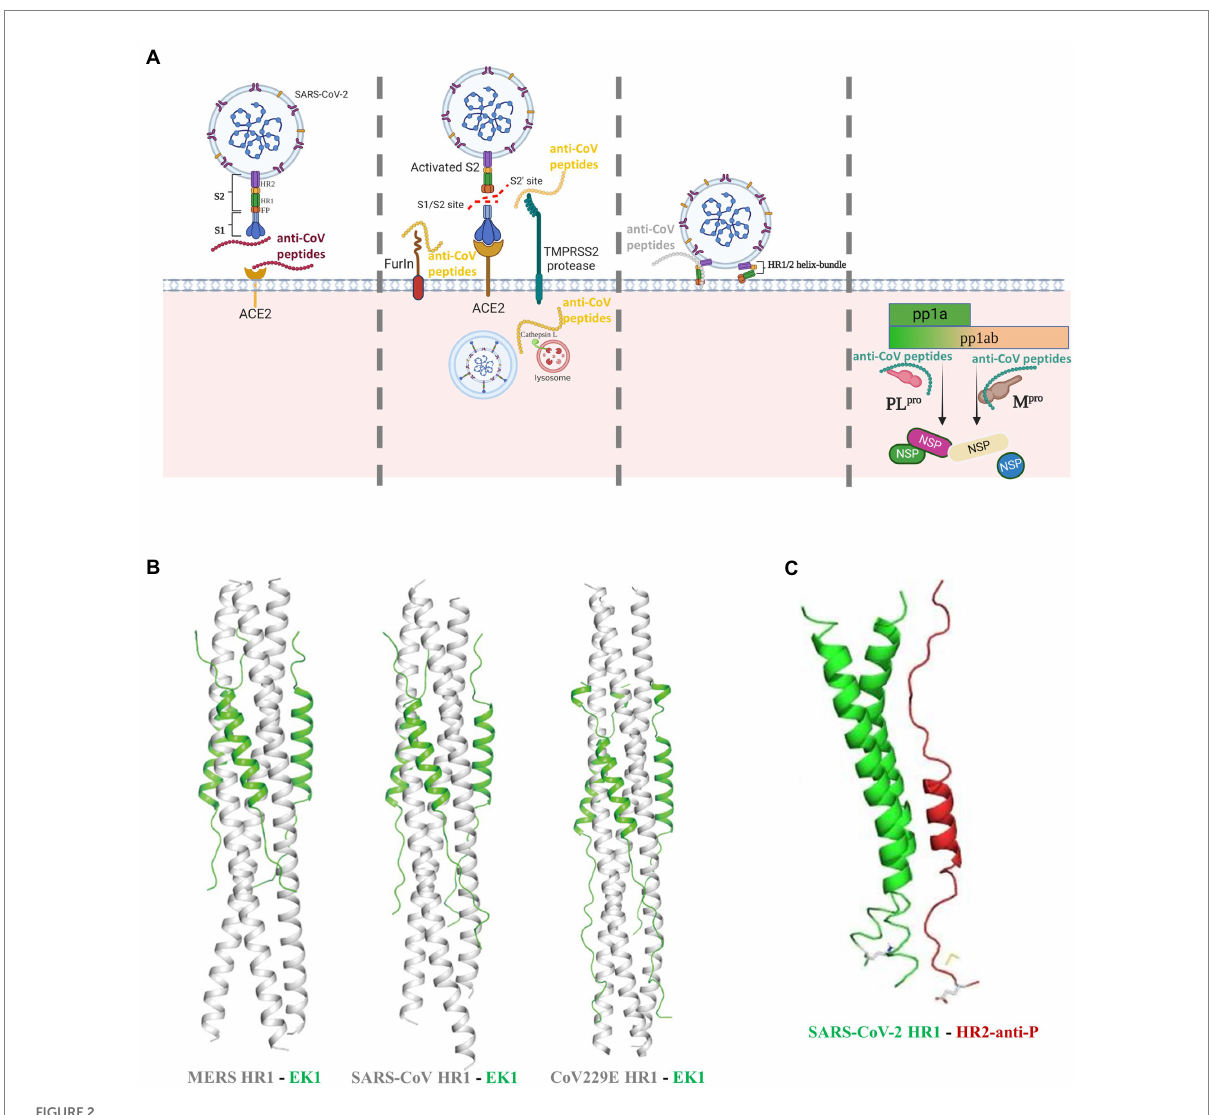
FIGURE 2 Peptides as potent inhibitors against coronavirus. (A) Anti-CoV peptides can work with diverse modes of actions by targeting the binding of S protein to host receptor, or the proteolytic processing of S proteins by host proteases, or the host-viral membrane fusion, or the viral proteases that are responsible for cleavage of replicase polyproteins into non-structural proteins. (B) The X-ray crystal structures of membrane-fusion inhibitory peptide EK1 shown as green in complex with the S protein HR1 regions of various CoVs shown as white (Xia et al., 2019b). (C) The X-ray crystal structures of membrane-fusion inhibitory peptide HR2-anti-P shown as red binding to the SARS-CoV-2 HR1 region shown as green (Ling et al.,